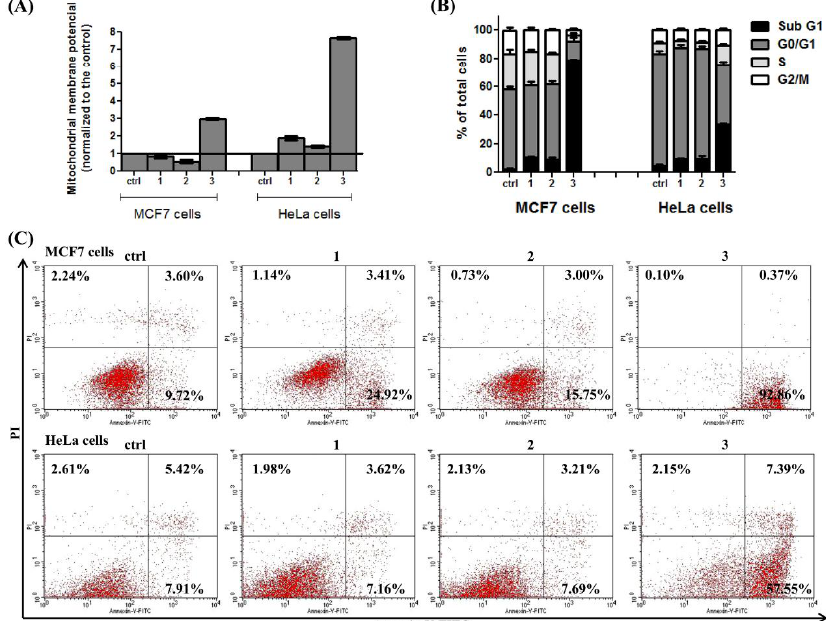
Figure 7. Flow cytometry analysis of MCF-7 and HeLa cells after 48 h of treatment with IC 50 concentrations of extracts and resveratrol: ( A ) mitochondrial membrane potential, normalized to the control; ( B ) cell cycle phase distribution expressed as % of total cell number; ( C ) apoptosis rates assessed by the Annexin V fluorescein isothiocyanate/propidium iodide kit. Ctrl—control; 1—dry extract; 2—subcritical water extract; 3—resveratrol.